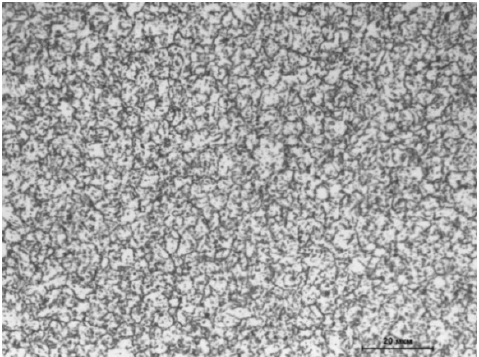
Figure 1. Structure of the ChS-139 steel after annealing.